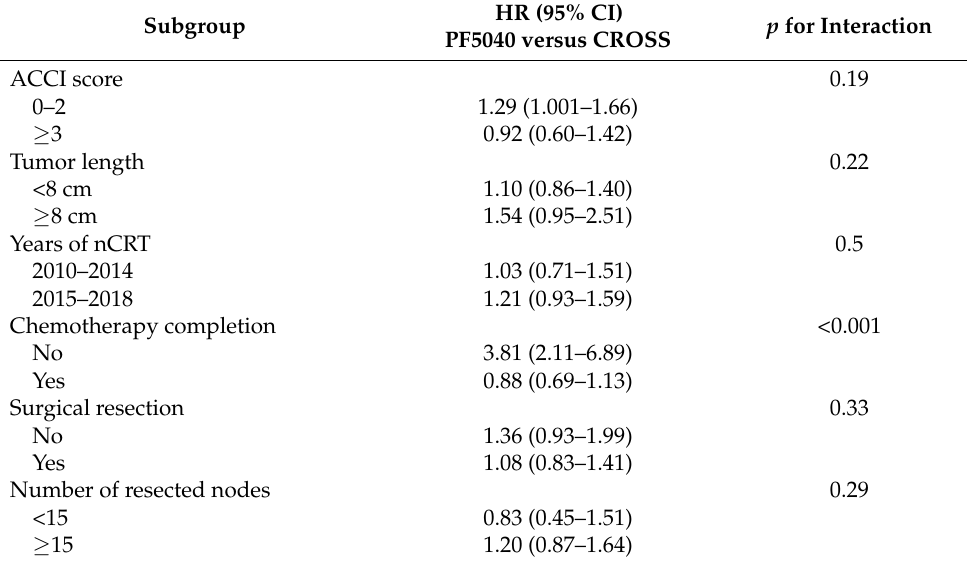
Table 4. Subgroup analysis of overall survival in the PF5040 versus CROSS groups, stratified according to pre-specified